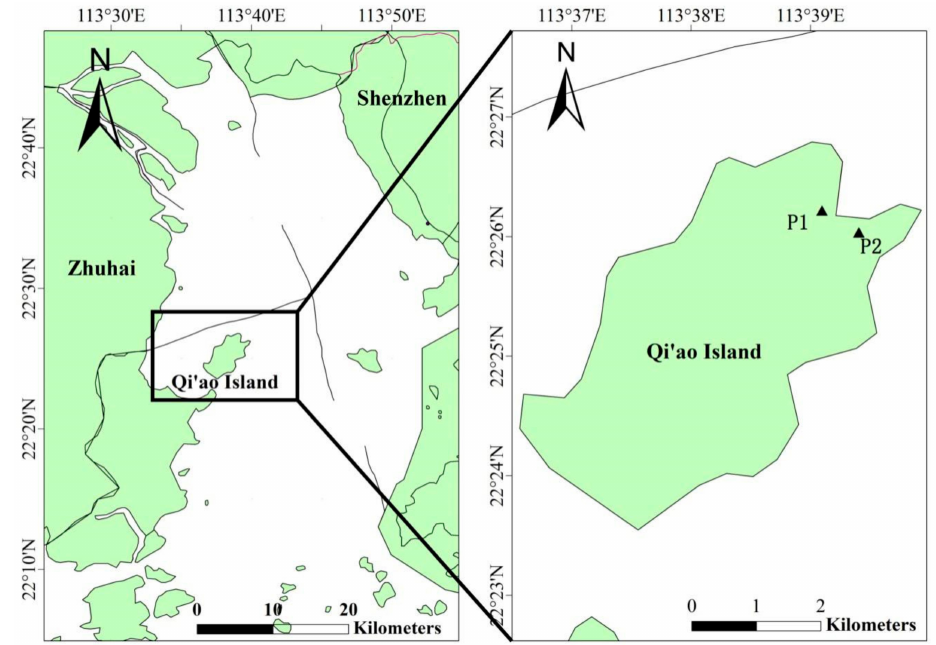
Figure 1. Map of the sampling sites. (P1: Community of K. candel ; P2: Community of B. gymnorrhiza